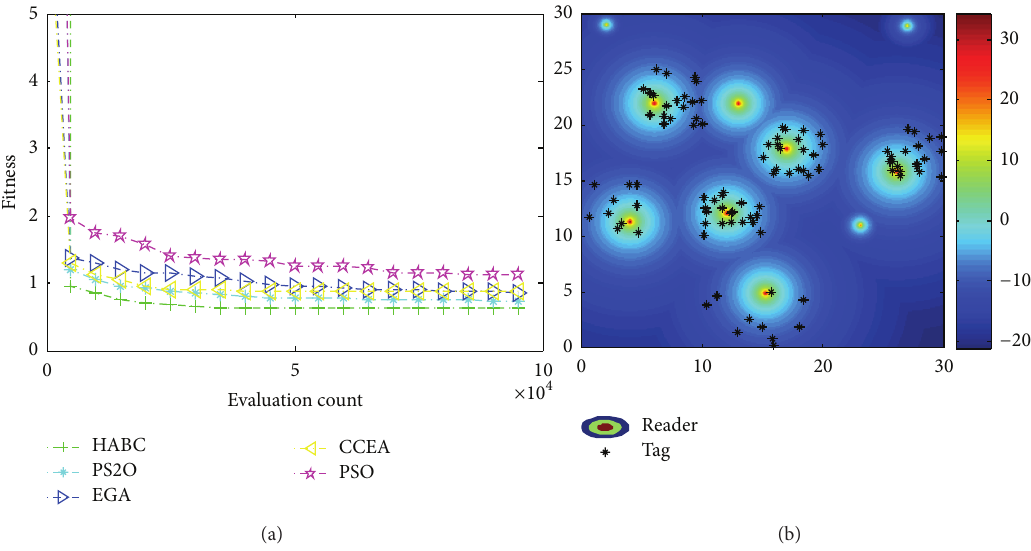
Figure 13: Results of the combined measurement. (a) Convergence process; (b) reader location and received power distribution.